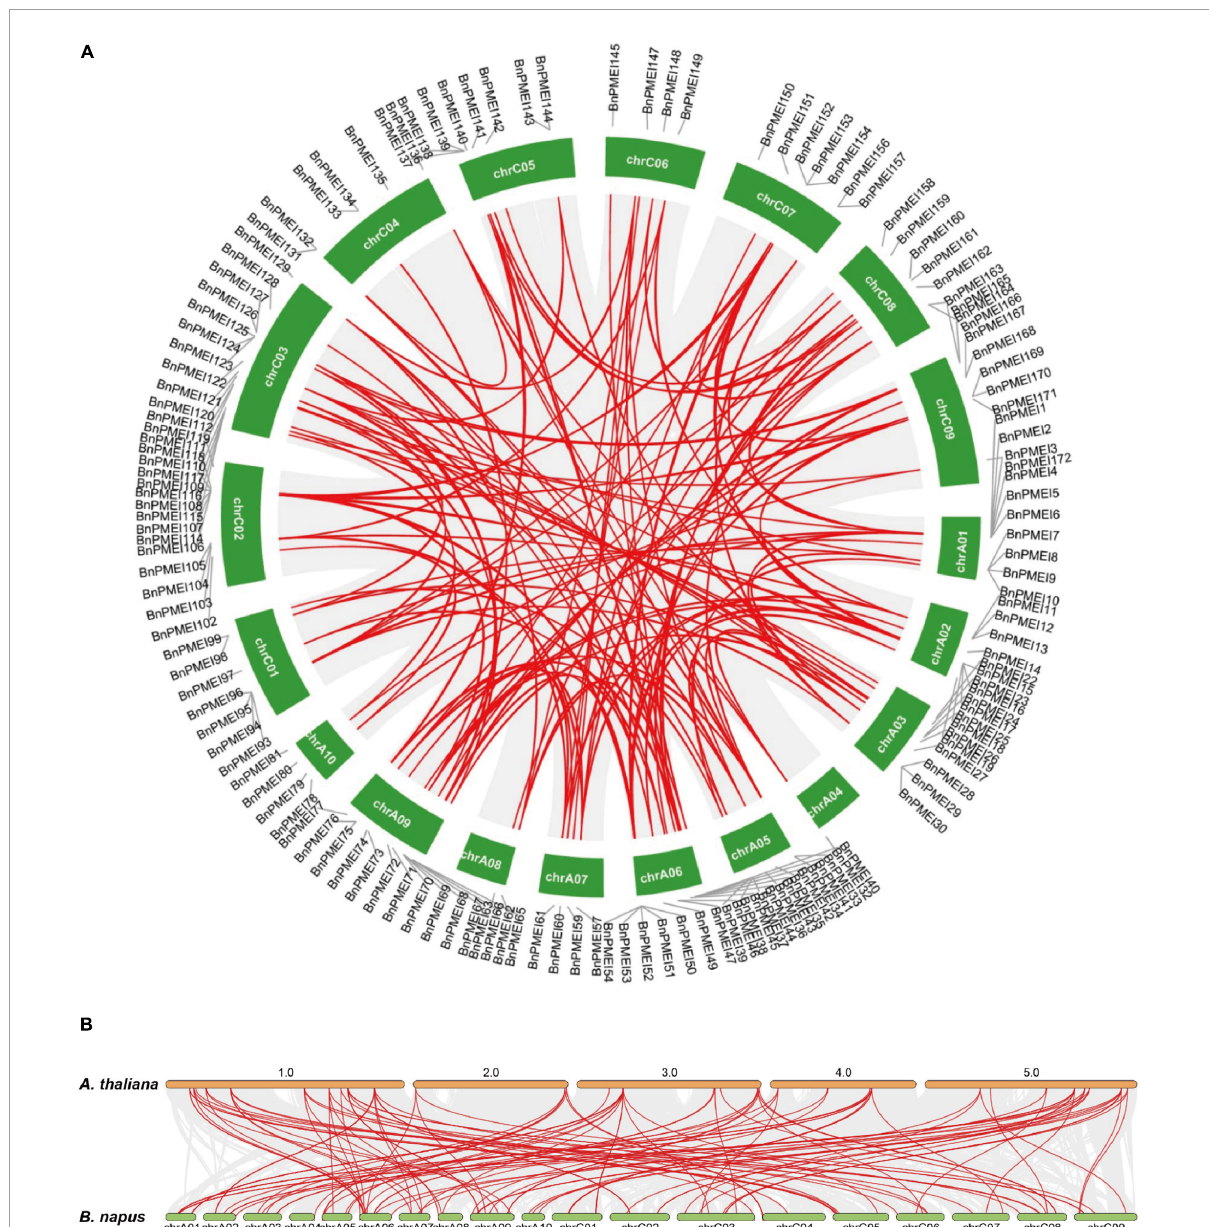
FIGURE4 (A) Synteny analysis of PMEI family in B. napus . Gray lines indicated all synteny blocks in the B. napus genome, and red lines highlighted the duplicated BnPMEI gene pairs. ID of chromosome was indicated in the middle of each chromosome. (B) Synteny analysis of PMEI family between B. napus and A. thaliana . Gray lines in the background indicated the collinear blocks within B. napus and A. thaliana genomes, while red lines highlighted the syntenic PMEI gene pairs. The specie names with the prefixes ‘ A. thaliana ’ and ‘ B. napus ’ indicated Arabidopsis thaliana and Brassica napus , respectively. ID of the A. thaliana chromosome was indicated on the top of each chromosome, and ID of B. napus chromosome was indicated at the bottom of each